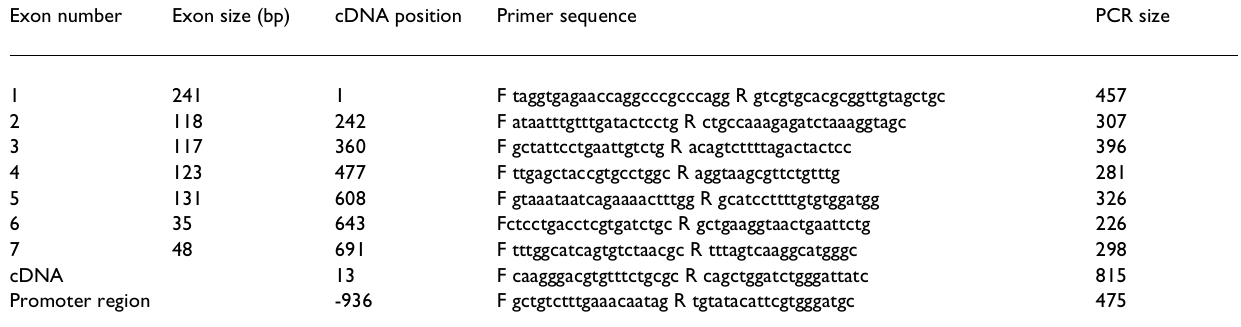
Table 1: Forward and reverse PCR primers used for amplification of the coding and promoter regions of